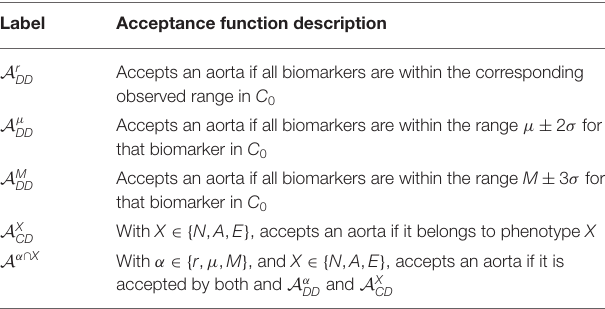
TABLE 4 | List of the acceptance functions that are used in the experiments related to clinically-driven-cohort generation.